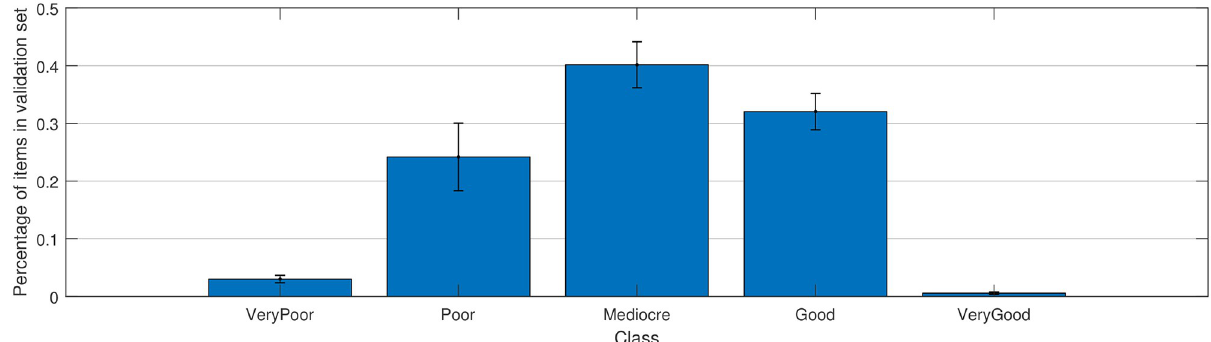
Fig 5. Average distribution of class predictions in percent across the five splits used for the fine-tuning of the feature extraction model. The error bars denote the standard deviation.